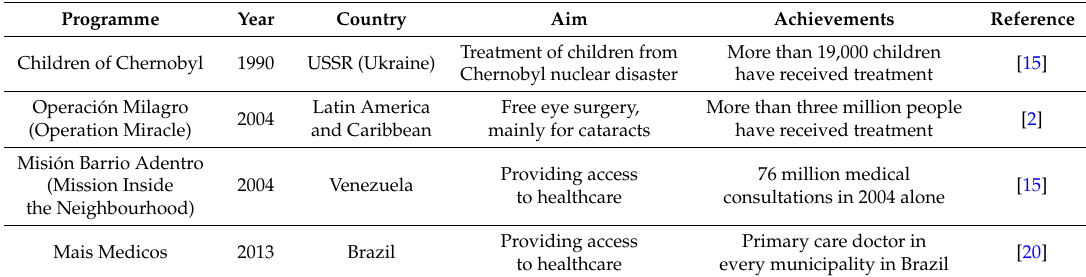
Table 4. Examples of international health